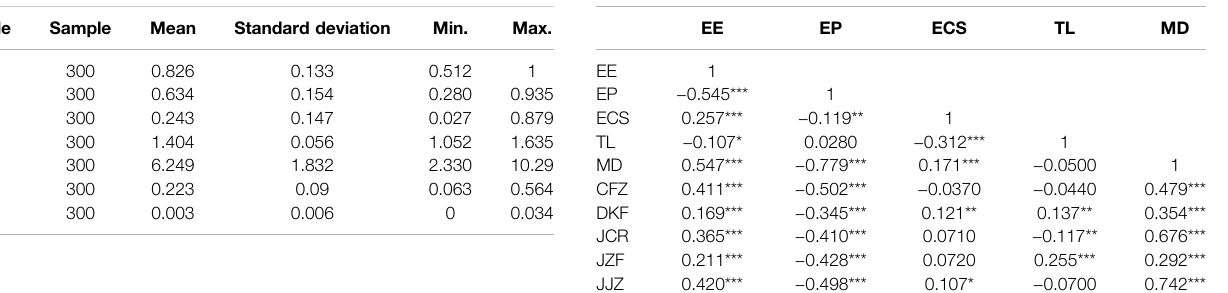
TABLE 3 | Variable description statistics. TABLE 4 | Correlation coef fi cients among